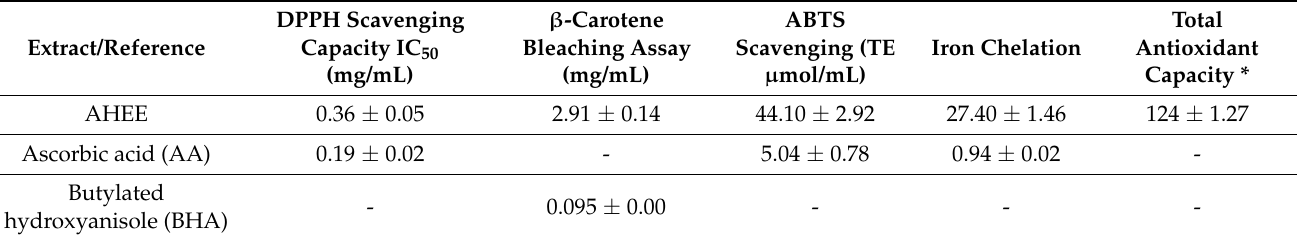
Table 8. Free radical scavenging and antioxidant capacity of AHEE. Values are expressed as mean ± SEM ( n =